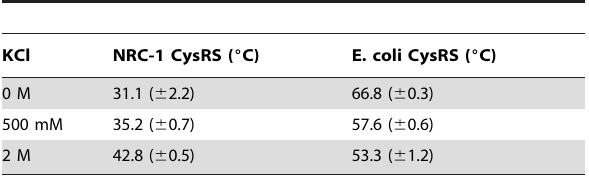
Table 1. Melting Transition Temperatures (T M ) for NRC-1 and E. coli CysRS {